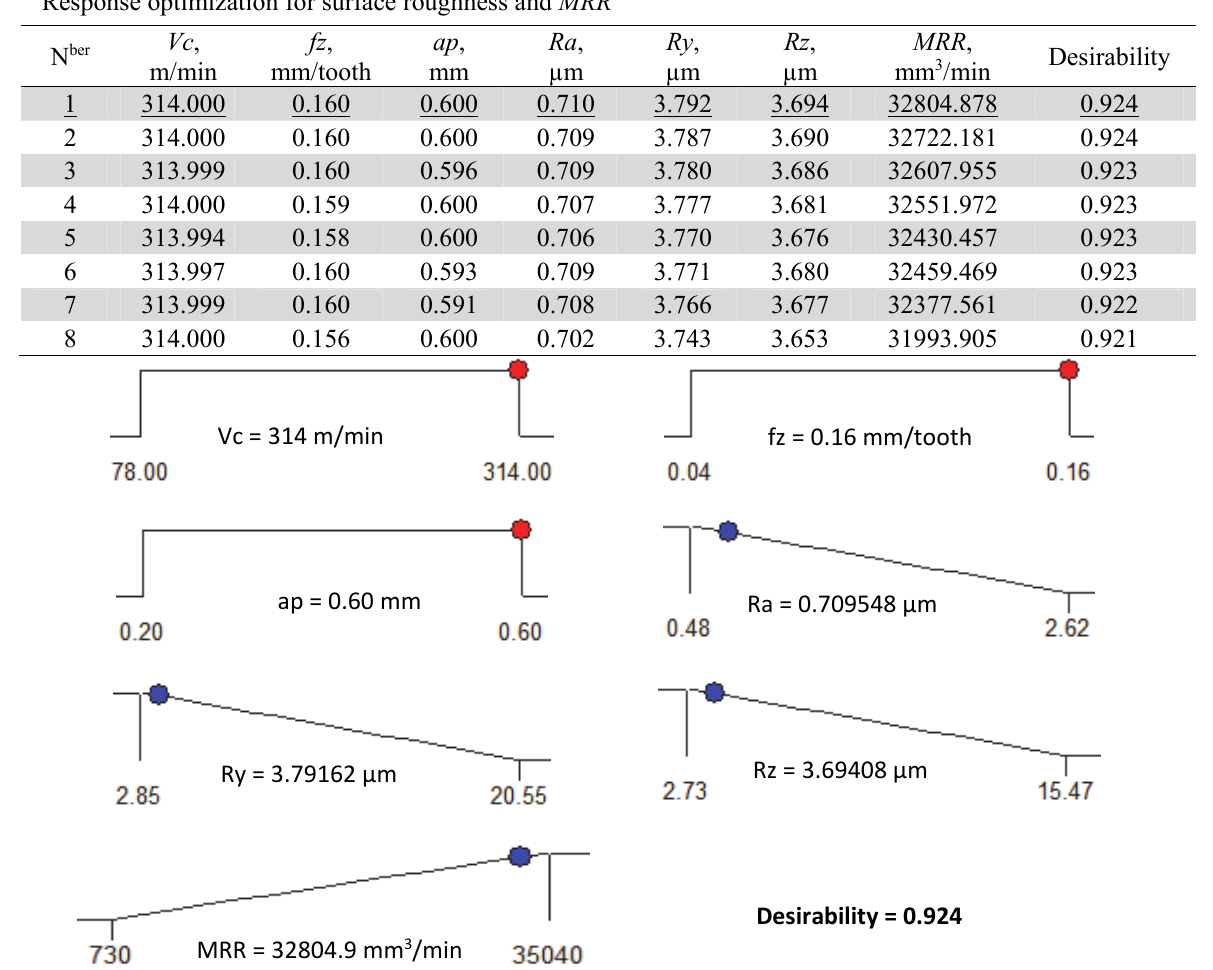
Fig. 10. Ram function graph for surface roughness and Material Removed